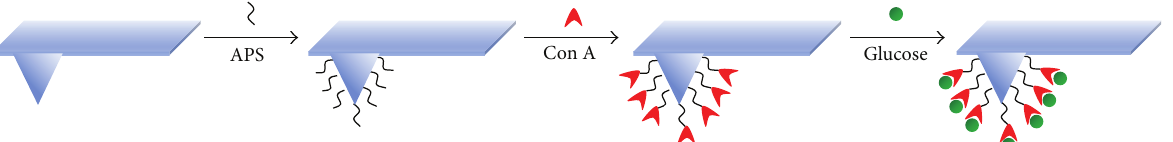
Figure 1: Schematic drawing of the cantilever modification procedure glucose detection by